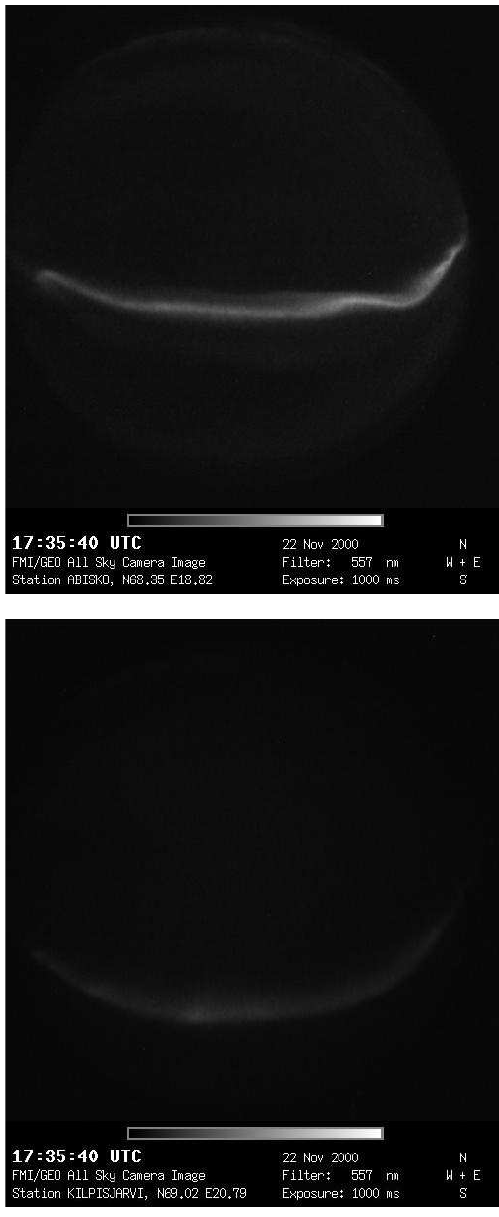
Fig. 15. Images acquired simultaneously by all-sky cameras in Abisko (top) and Kilpisj¨arvi (bottom). Both images show the same auroral arc.